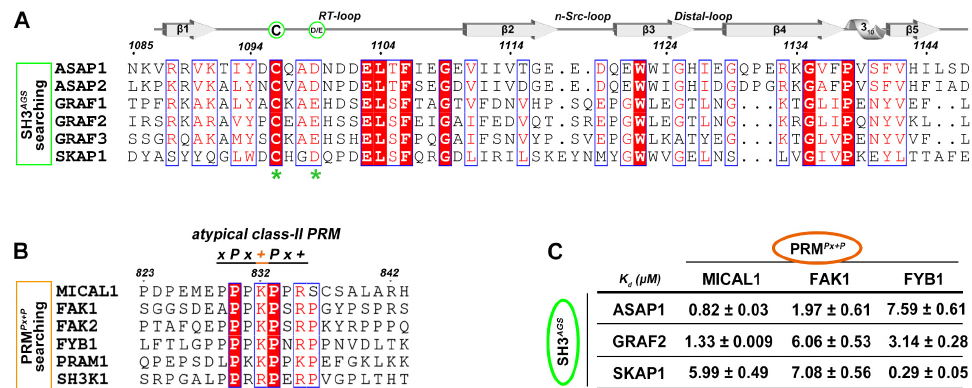
Figure 3. The SH3 AGS recognition to their targets with the high-affinity binding. ( A ) Sequence alignment of the SH3 domains of ASAP, GRAF and SKAP proteins showing their identical Cxx(D/E) sequence in RT-loop. The unique cystine and negatively charged residue are labeled by green circles and asterisks. ( B ) Sequence alignment of the PRM-containing proteins targeted by ASAP, GRAF and SKAP proteins indicating an atypical class-II PRM motif. The unique positively charged residue is highlighted in orange and labeled by orange asterisk. ( C ) ITC-based affinity measurements of between the SH3 AGS domains and their PRM Px+P targets.